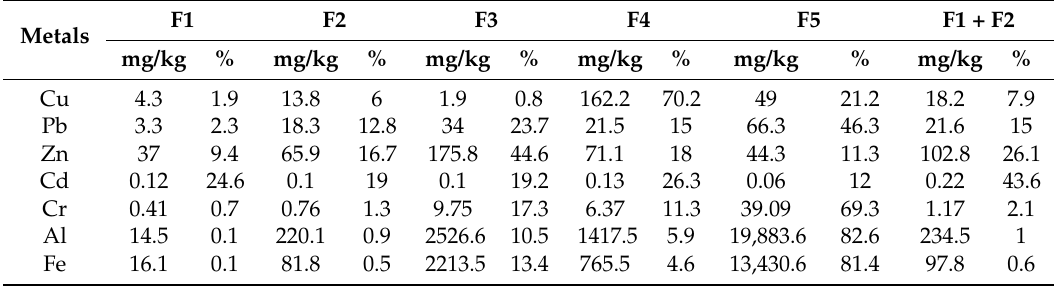
Table 3. Content and ratio of each chemical speciation of metals in settled